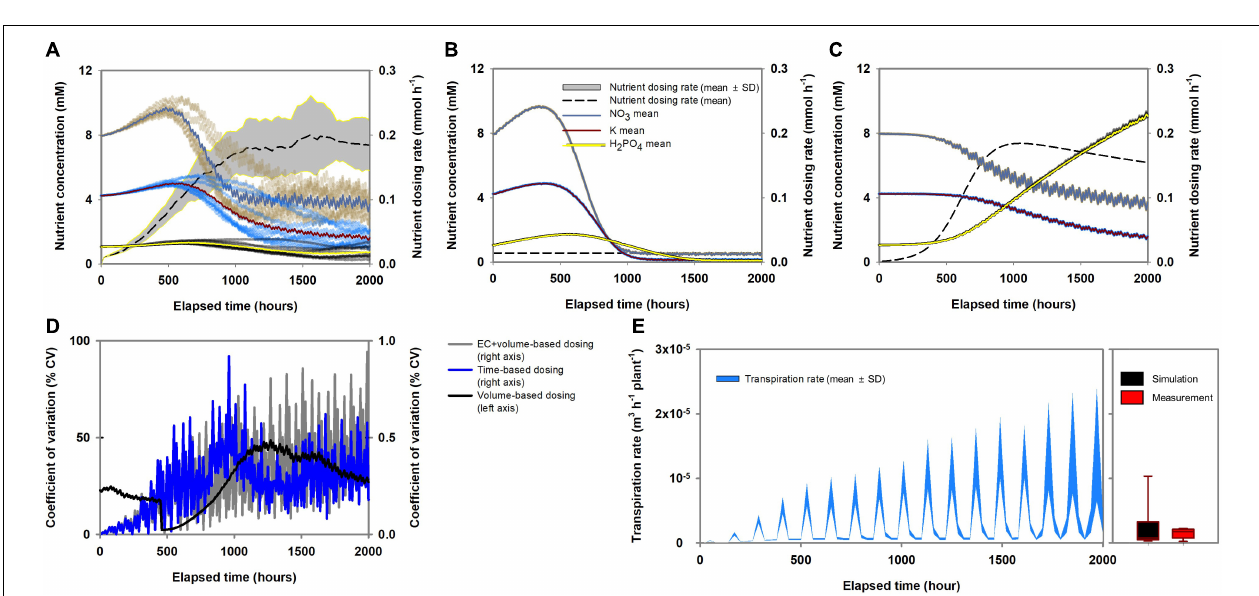
FIGURE 4 | Comparison between simulated and measured accumulated nutrient absorption of three Brassica species (A) and subsequent nutrients molar concentrations in the hydroponic system’s nutrient solution container (B) . (C) Distribution of percentage molar ratio of cations and anions in the nutrient solution container’s initial nutrient solution after replacing the weekly used nutrient solution around the Steiner’s standard percentage molar ratios.